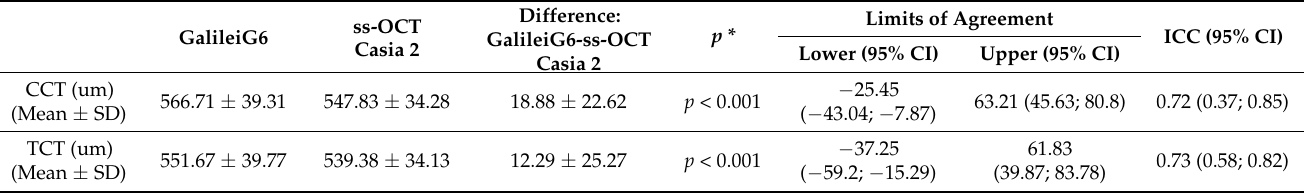
Table 3. Table comparing central corneal thickness CCT (um), TCT (um) measured with OCT Casia 2 and GalileiG6 Dual Scheimpflug Analyzer. ICC (introclass correlation coefficient) refers to the correlation between